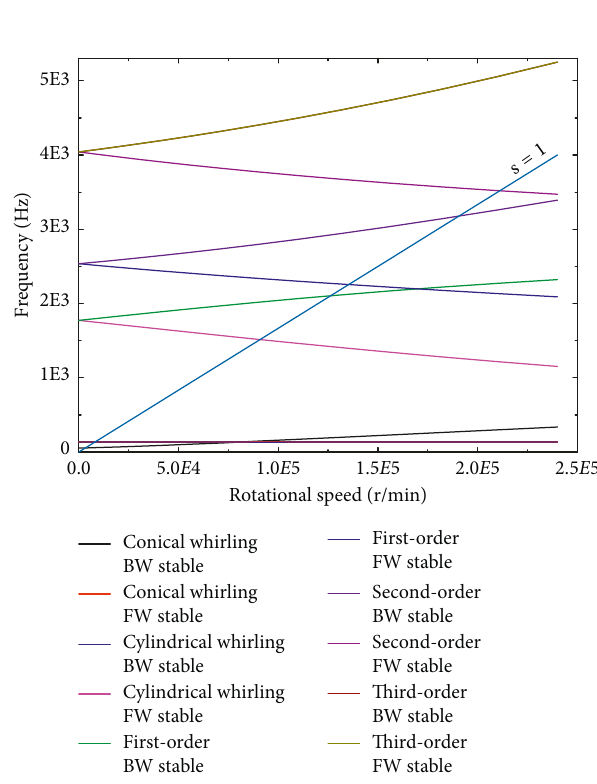
Figure 4: Campbell diagram of ACM